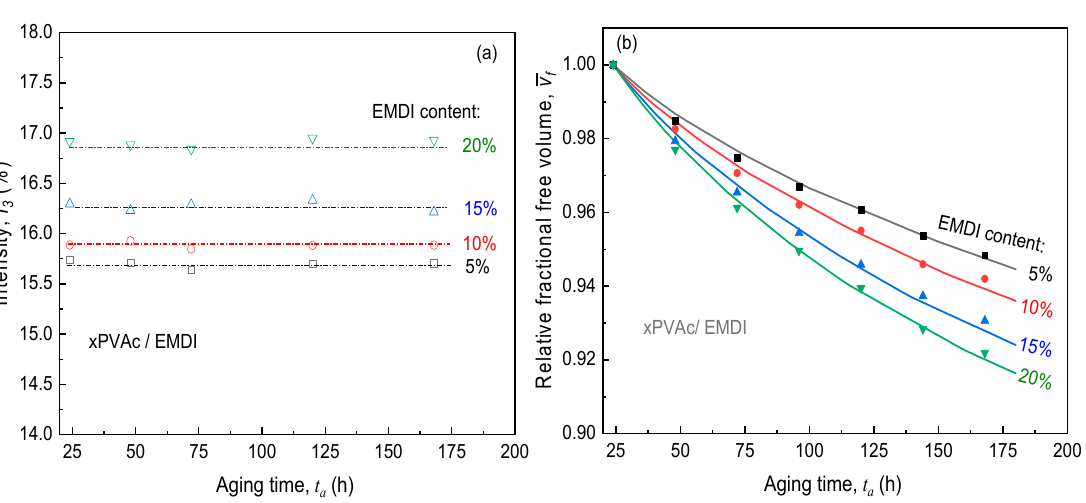
Figure 8. Evolution of ( a ) intensity I 3 of o-Ps and ( b ) relative fractional free volume (Dots: experimental data; Curves: calculated by vacancy diffusion model) in cured EPI film during physical aging.